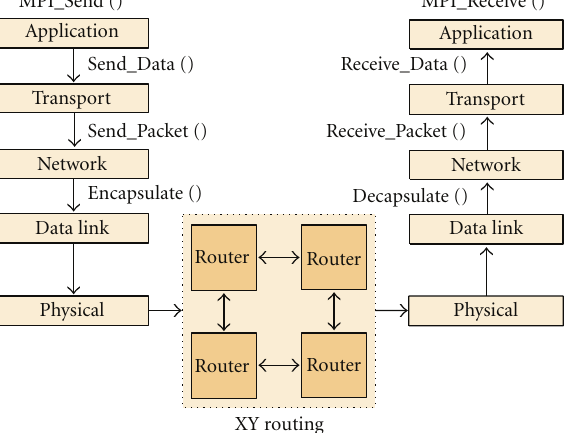
Figure 11: HS-Scale protocol